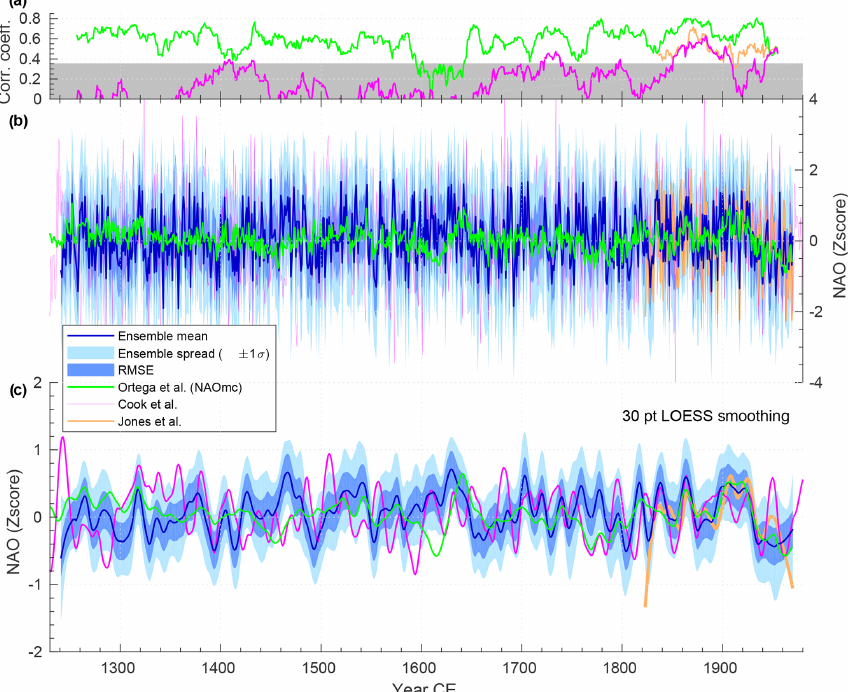
Figure 15. (a) Moving 31-point correlation between reconstructed DJF NAO from this study and Cook et al. (2019) (magenta), Ortega et al. (2015) (green) and observed NAO (yellow) (Jones et al., 1997). Correlations beyond the gray shaded area are significant ( p < 0 . 05). (b) Ensemble mean reconstructed NAO (PC1 of reconstructed SLP, Hurrell et al., 2003) with error estimated by ensemble spread and RMSE, compared to observed NAO (Jones et al., 1997) and NAO reconstructions by Cook et al. (2019) and Ortega et al. (2015). The amplitude of all time series are scaled to fit the decadal variability in the observed NAO. (c) Same as (b) , except filtered with a 30 point “loess” filter.